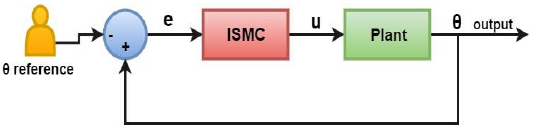
Fig. 2. The shape of sliding surface [2].